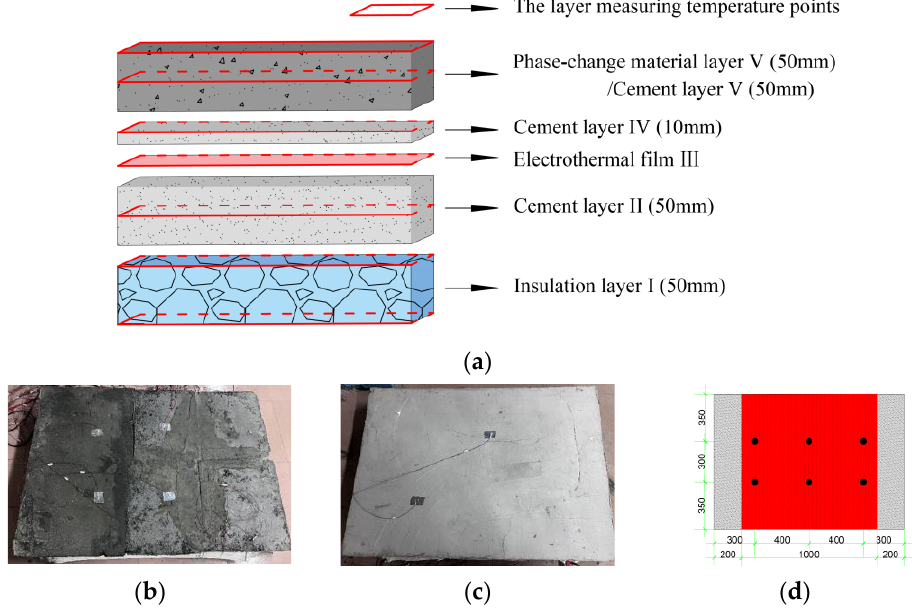
Figure 8. Layout of experimental wallboard and measuring points. ( a ) Phase change/cement wallboard. ( b ) Picture of the PCM wallboard. ( c ) Picture of the cement wallboard. ( d ) Layout plan of temperature measuring points.